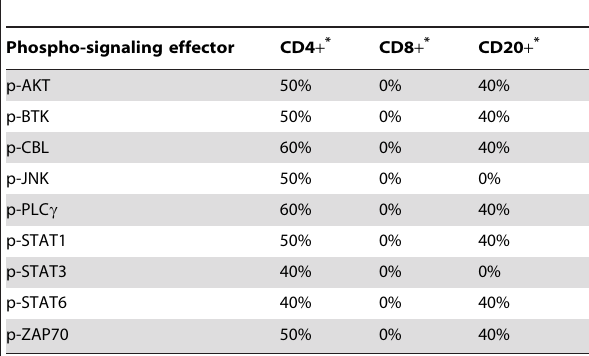
Table 2. ERA PB phospho-signaling is distinguished from OA PB in the CD4 + and CD20 + cell